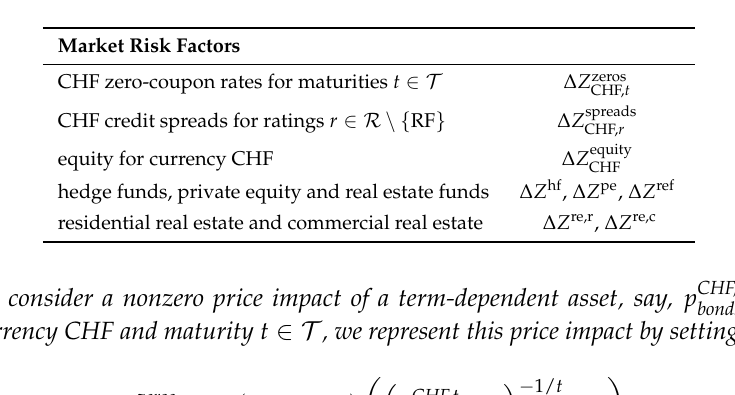
Table 3. Market risk factors considered for modeling the market impact caused by the sale of assets in large